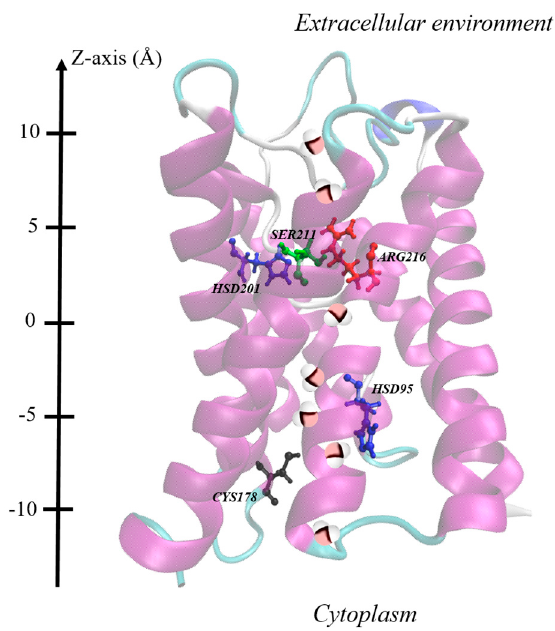
Figure 2. Depiction of layout of the residues considered with the + z orientation coinciding with the vertical bottom-to-top direction, for which rearrangements are particularly evident in the regions of the respective pore mouths (see main text). At the upper side (extracellular end), SER-211 (depicted in green), ARG-216 (depicted in red) and HSD-201 (depicted in blue). These latter two residues are usually referred to as the selectivity filter), and, at the lower side (cytoplasm end), CYS-178 (depicted in black) and HSD-95 (depicted in blue). These two have been recently suggested as a gating site by Alberga et al. [37]. The lining of water molecule inside the pore is also represented. Table 1. Summary of pores A, B, C, and D, the four aquaporin channels (an example of a single aquaporin channel is reported in Figure 2), which undergo appreciable rearrangement in static-field pulses along the ˘ y -axis. This is defined as a heavy-atom root-mean squared deviation (RMSD) of more than 1 Å with respect to the initial position.